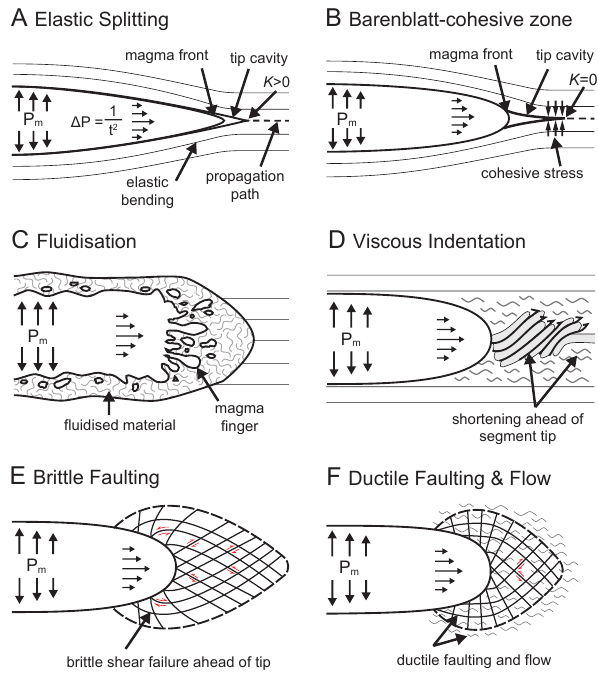
Figure 1: Propagation mechanisms for intrusion